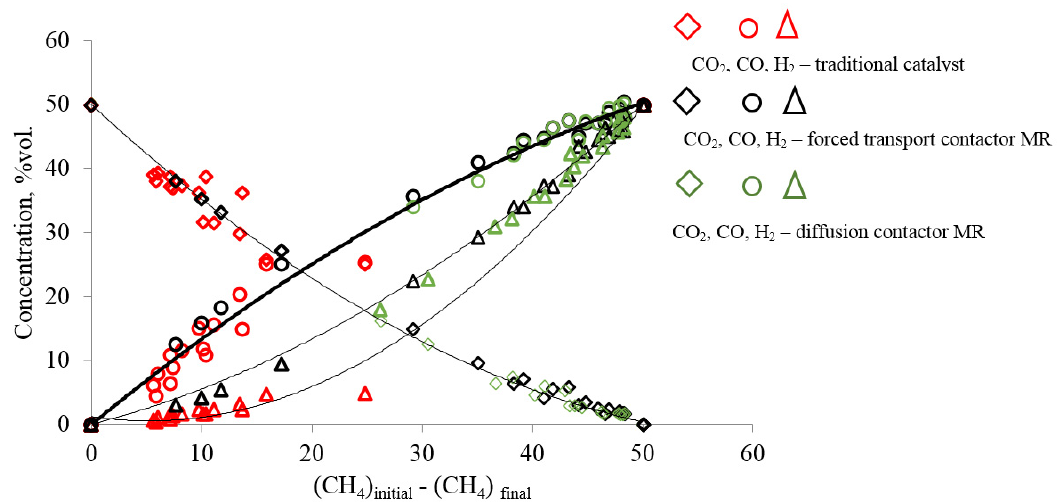
Figure 3. Dependence of the change in the concentrations of CO 2 , CO and H 2 on the change in the amount of methane reacted on the membrane and traditional catalysts, when the temperature of the DRM process changes from 820 °C to 890 °C on the MC, and the flow rate of the reagent mixture changes from 40 to 150 cm 3 (at standard)/min in the modes of the contactor with diffusion and forced transport of the reagent mixture. (For a membrane catalyst in a mode with forced transport at 820 °C, the interval of the consumption of the reagent mixture was increased and ranged from 40 to 320 cm 3 /min).